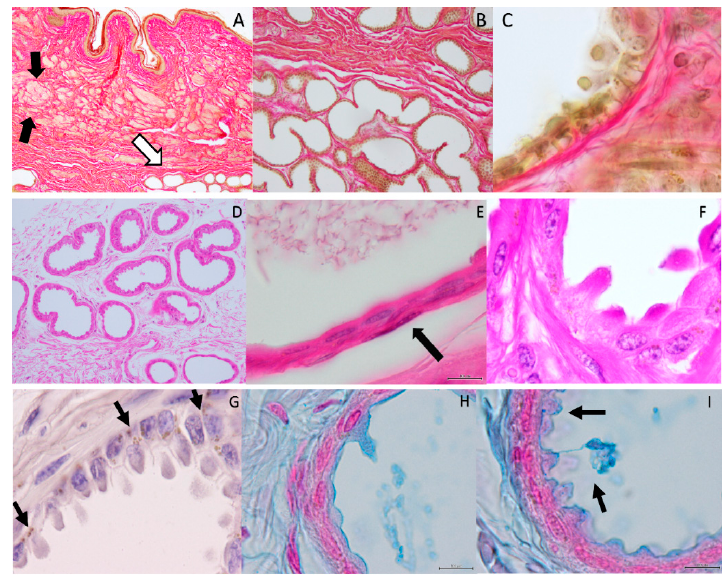
Figure 2. Histology-Bar = 100 µm. Van Gieson's Stain . ( A ) Organization of the inguinal sinus presenting sebaceous (black arrows) and acinar glandular fields (white arrow); ( B ) collagen fibers sustain the secretory epithelium of the acinar glands that presents; ( C ) cellular protrusions towards the glandular lumen (apocrine secretion). Parenchyma rich in glycogen can be observed and its amount varies in different areas of the gland being the secretory cells in different stages of secretion production in different areas of the gland–PAS; ( D – F ); In ( E ) the arrow points out a myoepithelial cell. ( D ) = 40× magnification; ( E ) = 1000×. Visualizations of lipid granules with Sudan black stain; ( G ) Alcian blue stain depicts mucin content; ( H , I ) Magnification = 1000×.